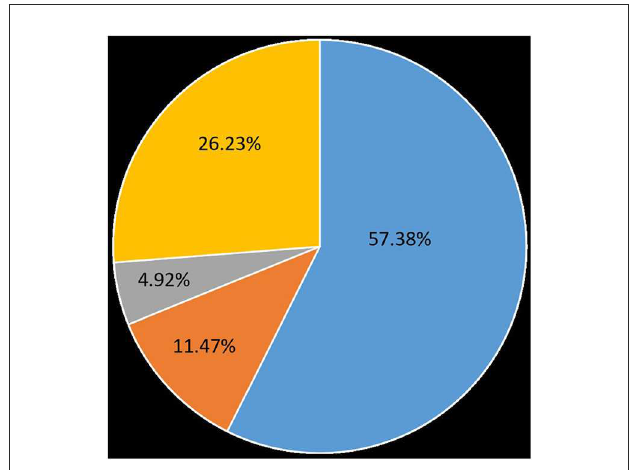
FIGURE4 Effectiveness of carbamazepine on patients with glossopharyngeal neuralgia. 57.38% were on complete remission, 4.92% were on partial remission, early-stage effective accounted for 11.47%, 26.23% took carbamazepine without remission.